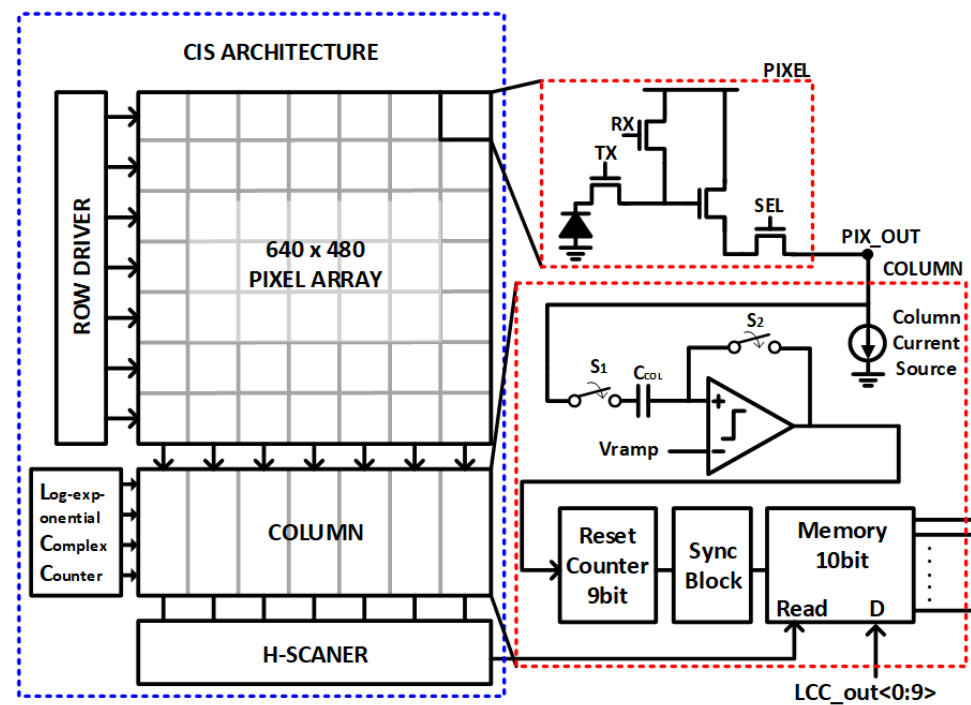
Figure 2. Full block diagram of the proposed CIS.